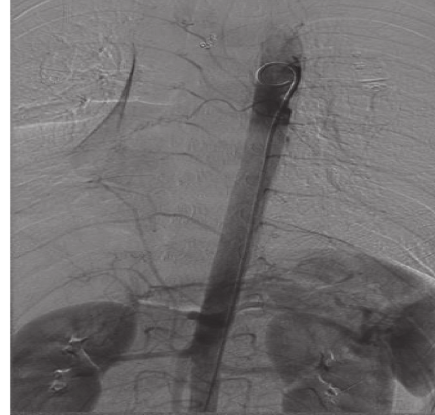
Figure 4: Aortic angiography showed an ectopic bronchial artery originating from the right renal artery and entering the right lower lung with tortuous and disordered peripheral vessels; the pul- monary artery branch is shown in the arterial stage.